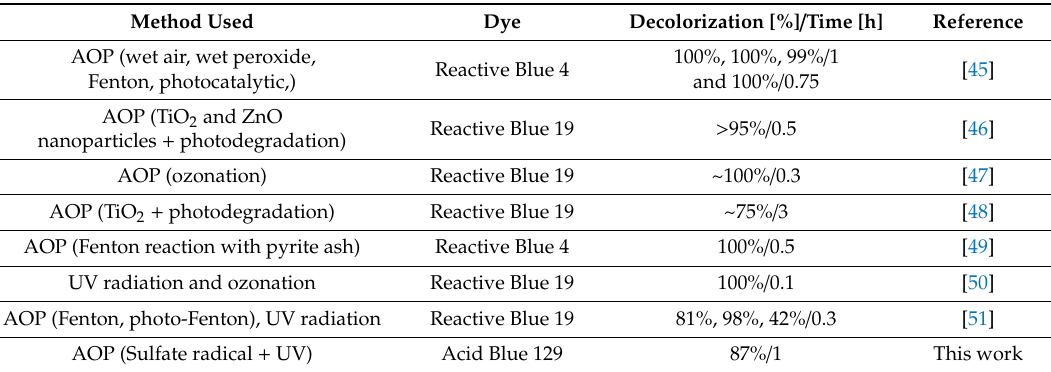
Table 2. Methods used to degrade anthraquinone